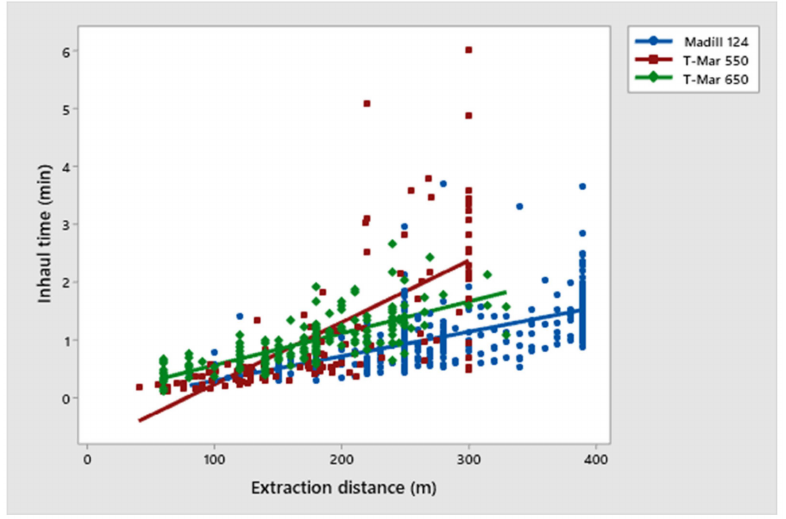
Figure 4. Relationship between inhaul time and extraction distance for the three yarders